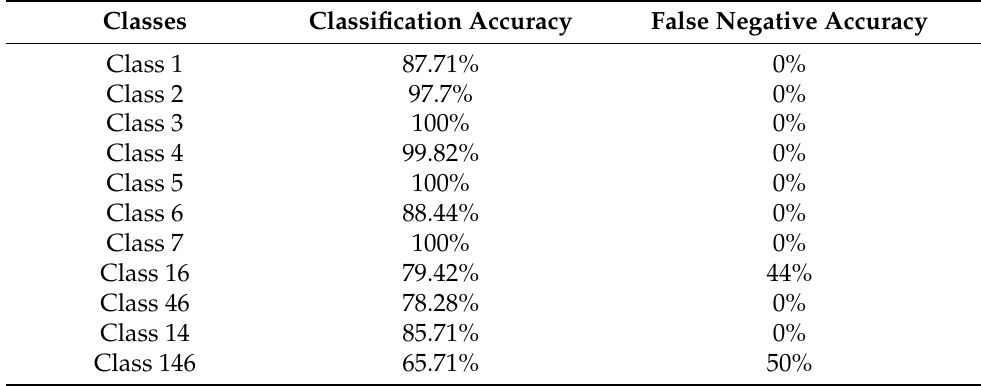
Table 3. Accuracy of single and multiple source PRPD